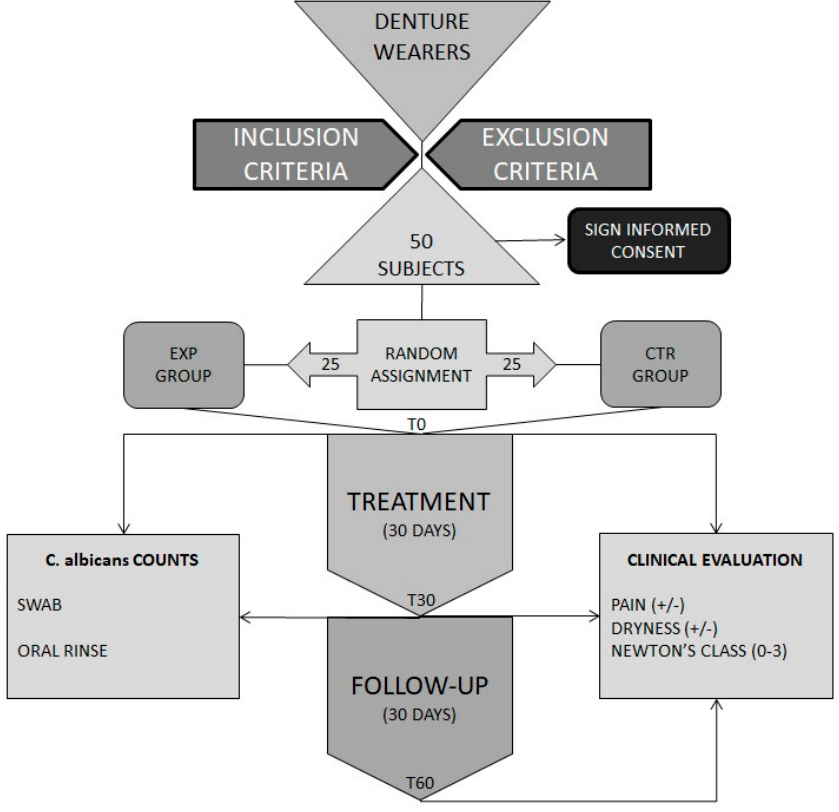
Figure 1. Experimental study design.